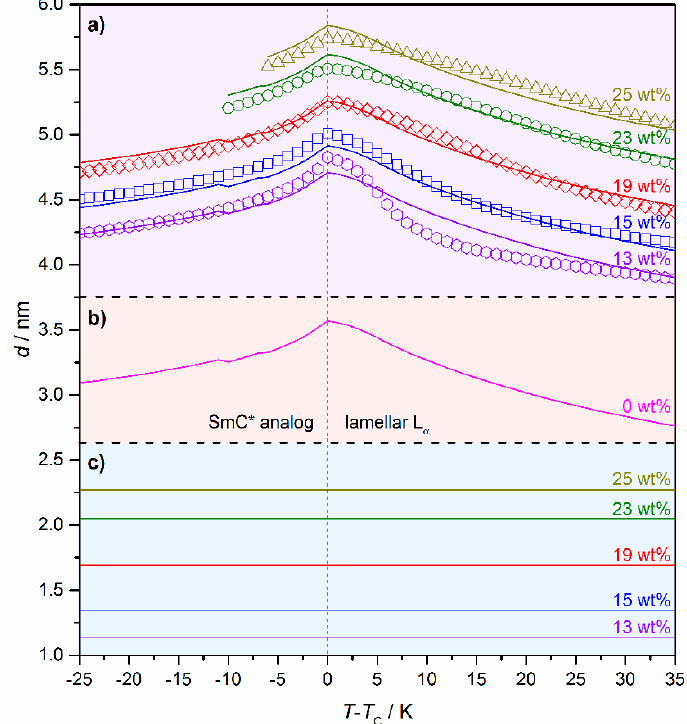
Figure 18. ( a ) Temperature and concentration-dependent measurements of the lamellar repeat unit d of the system 4 / formamide. The weight fraction w of formamide is given in the graph. Measured data points are depicted as symbols, while the lines represent fits according to the Equations (2) and (3). ( b ) Calculated thickness of the amphiphile bilayer d bl (T) of a hypothetic SmC* phase in the neat state. ( c ) Calculated solvent layer thickness d s (w) for the different weight fractions w of formamide. (Reprinted by permission from Springer Nature: [13].)